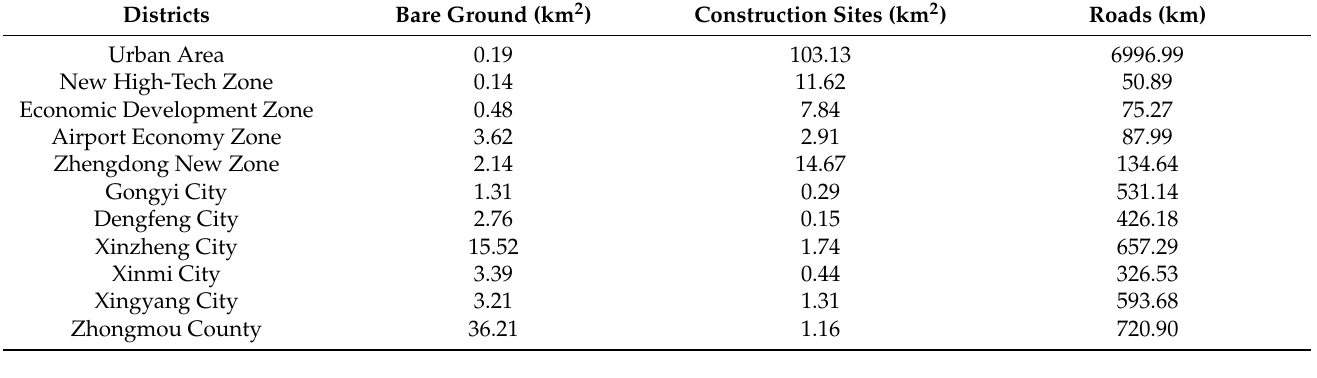
Table 3. Area or length of each dust source in different districts.